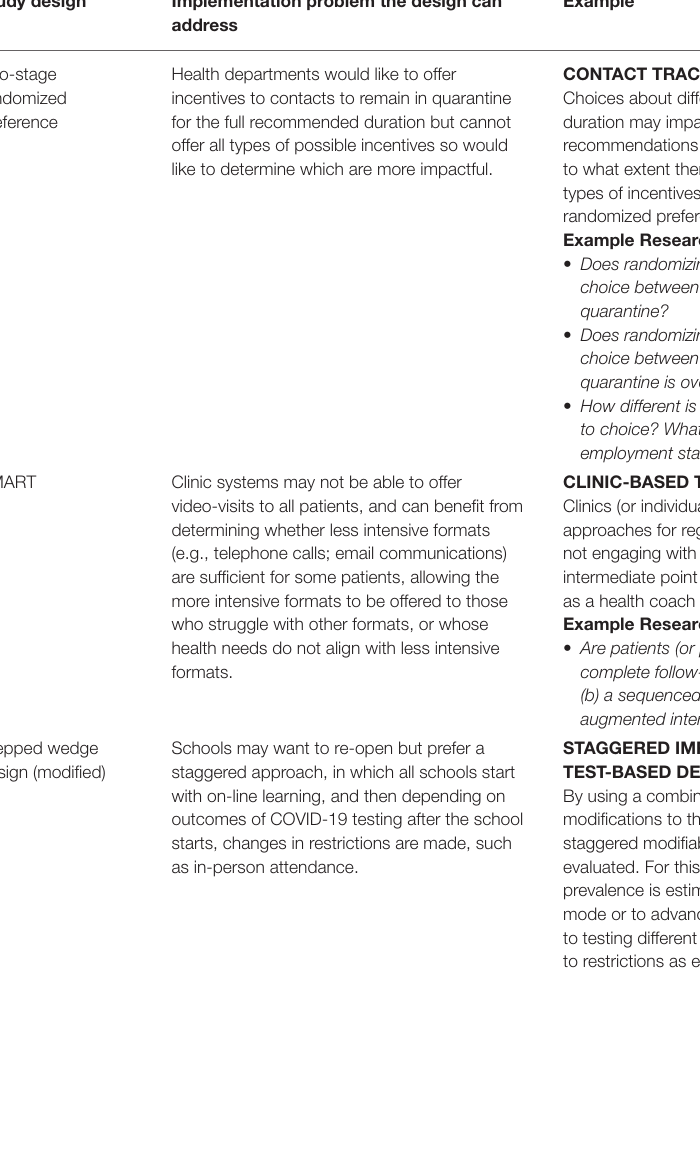
TABLE 3 | Pragmatic study design examples applied to community interventions during